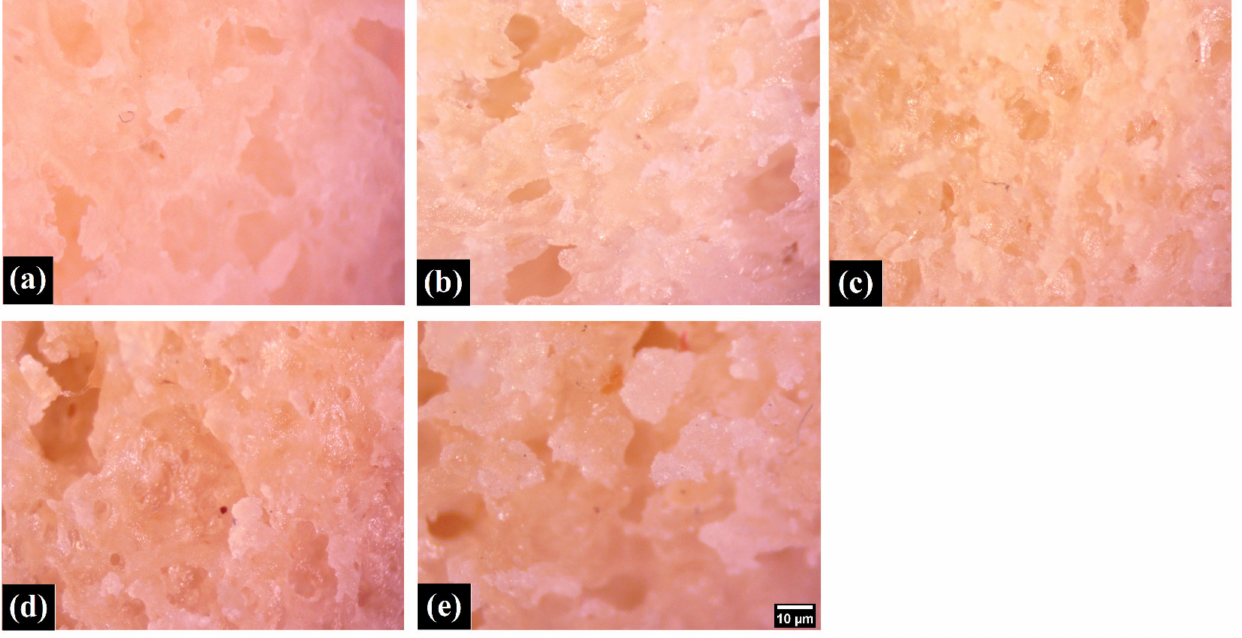
Figure 5. The micrographs of the various samples show the cross-section of the samples. ( a ) WF0; ( b ) WF25; ( c ) WF50; ( d ) WF75; ( e ) WF100. (Scale bar: 10 µ m—the same magnification for all